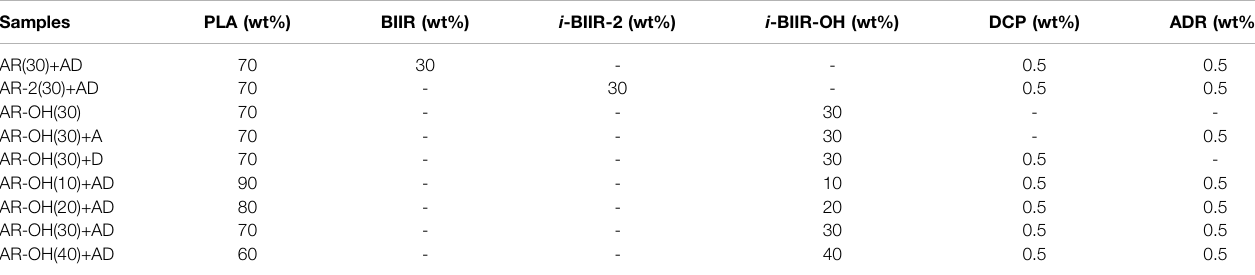
TABLE 1 | Sample compositions.